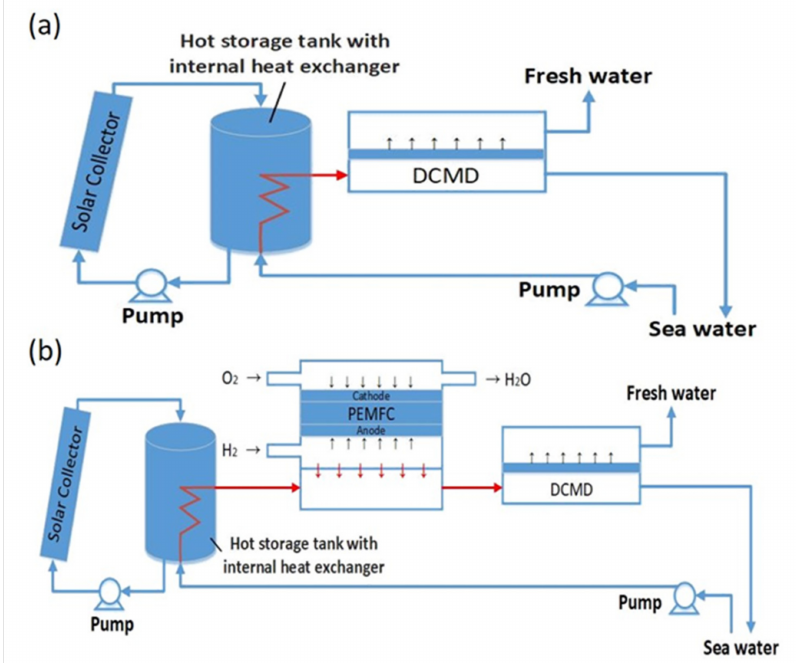
Figure 1. Schematic diagram of ( a ) the solar-heated membrane distillation system and ( b ) the PEMFC coupled solar-heated membrane distillation